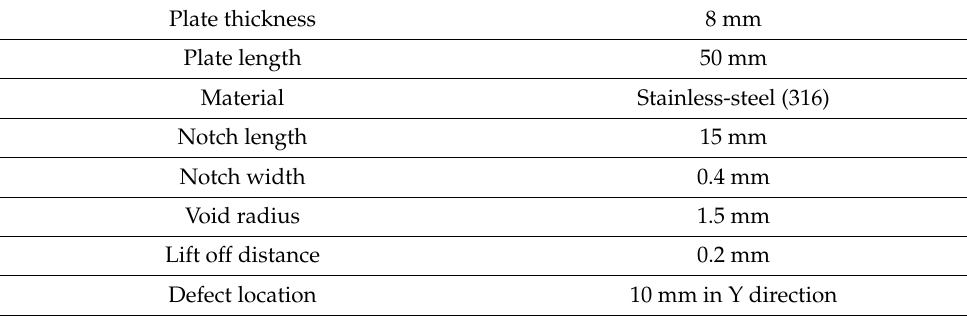
Table 2. Parameters Used for Both Simulation Cases.